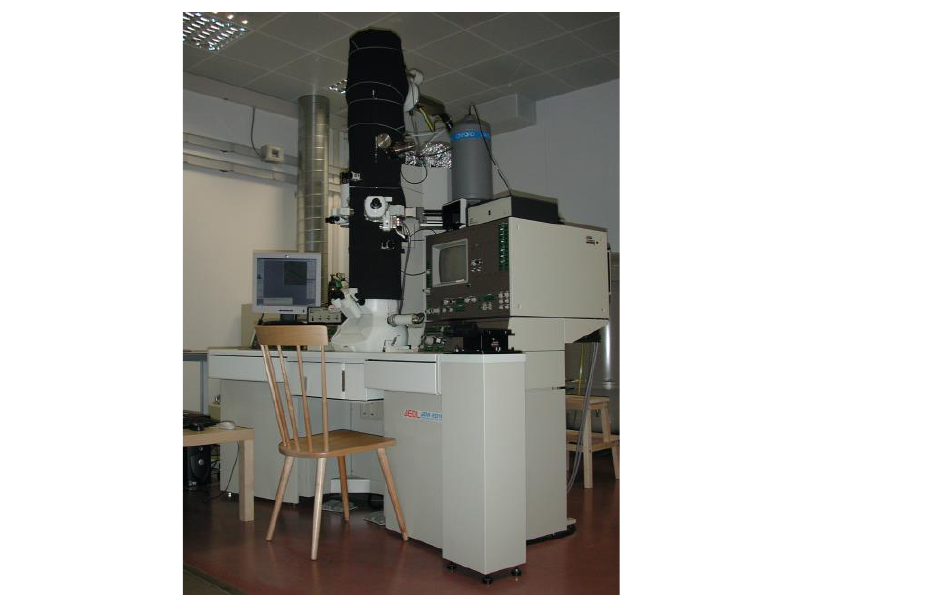
Figure 2. Photograph of one TEM/STEM laboratory at the ‘Istituto Officina dei Materiali’ of the Italian National Research Council (IOM CNR) in Trieste, showing a classic colonial wooden chair, which was used by the operator to prevent magnetic noise during the experiments.